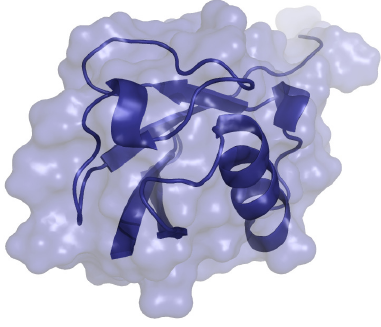
Figure 7. Structure of ubiquitin.